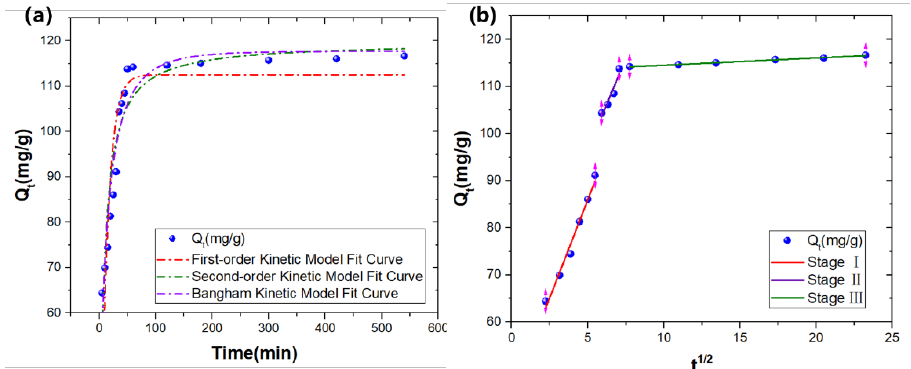
Figure 5. Adsorption of DEMs onto cotton fabrics. Fitting of data to ( a ) the pseudo-first-order kinetic model, the pseudo-second-order kinetic model, the Bangham kinetic model and ( b ) the Weber and Morris intraparticle diffusion.